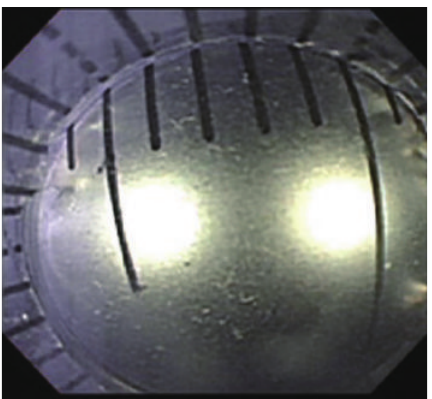
Figure 4: The calibrated hood in endoscopic view was placed directly over the